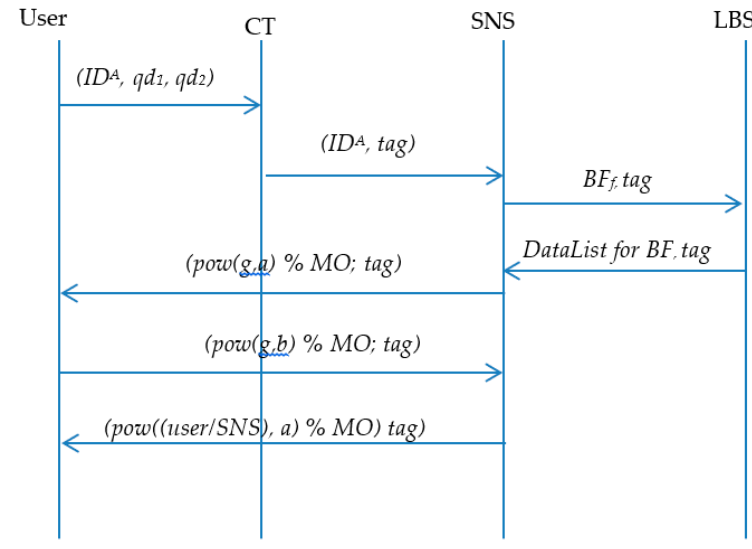
Figure 7. BLoom filter + Oblivious Transfer sequences of querying users locations.